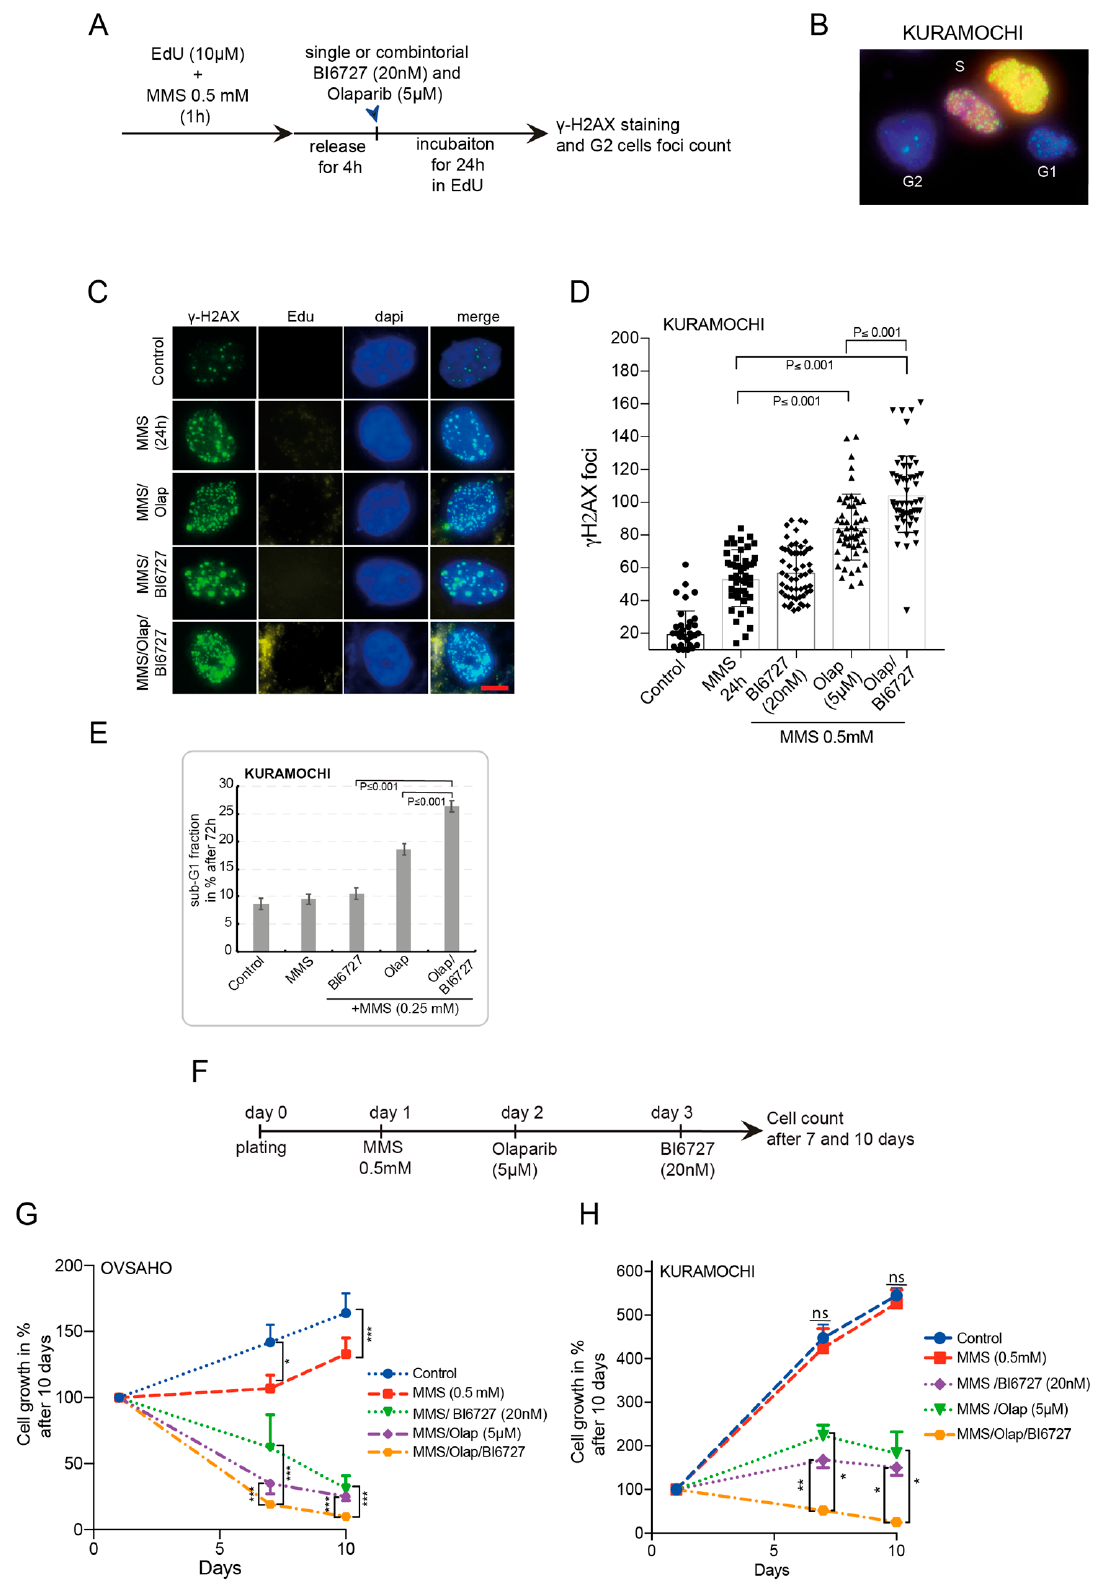
Figure 4. Combining PLK1i and PARPi enhances the DNA damage effect of MMS and reduces the viability of BRCA2-deficient HGSOC with KRAS amplification. ( A )—Treatment schedule: KURAM- OCHI cells were EdU labeled and pulse-treated with MMS (0.5 mM) for 1 h. The cells were released in EdU-containing medium for 4 h, then treated with the single agents or combined for 24 h in the